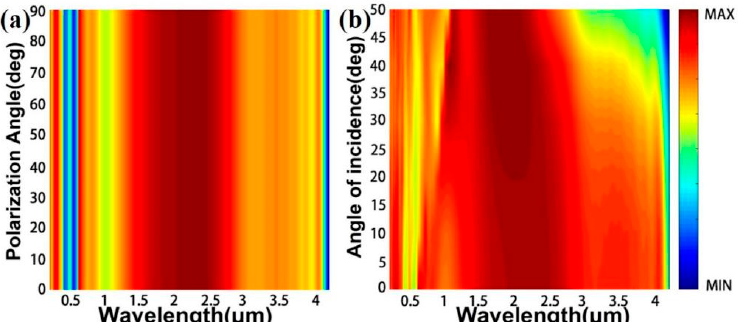
Figure 10. Absorption spectra of the designed solar energy absorbers under ( a ) different polarizations and ( b ) incident angles.